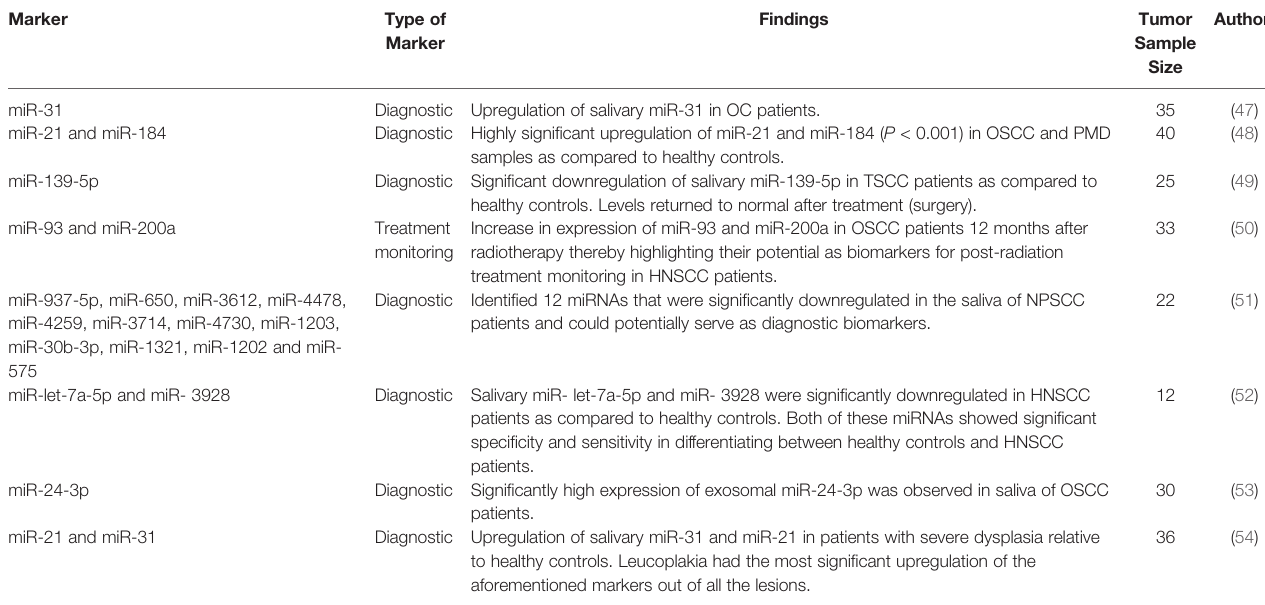
TABLE 2 | Circulating miRNA markers for HNSCC. Marker Type of Marker